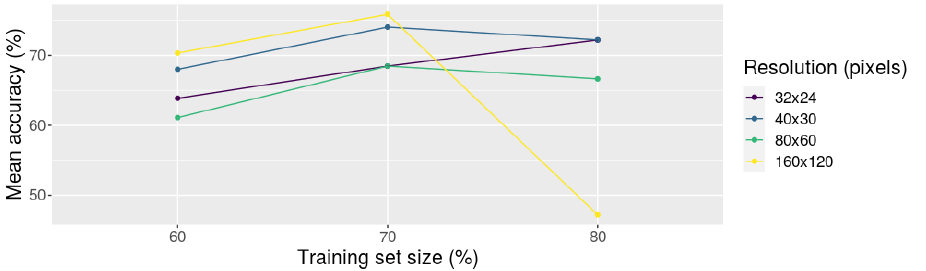
Figure 7. Interaction plot of the proportion of the base set used for training (80%, 70%, and 60%) and resolution (32 × 24, 40 × 30, 80 × 60, and 160 × 120 pixels) using the accuracy values obtained from experiment